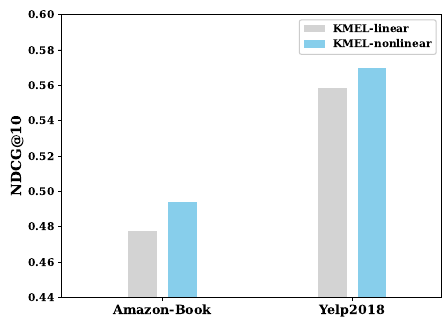
Figure 5. Performance of the proposed KMEL with linear and nonlinear interaction on Amazon-Book and Yelp2018